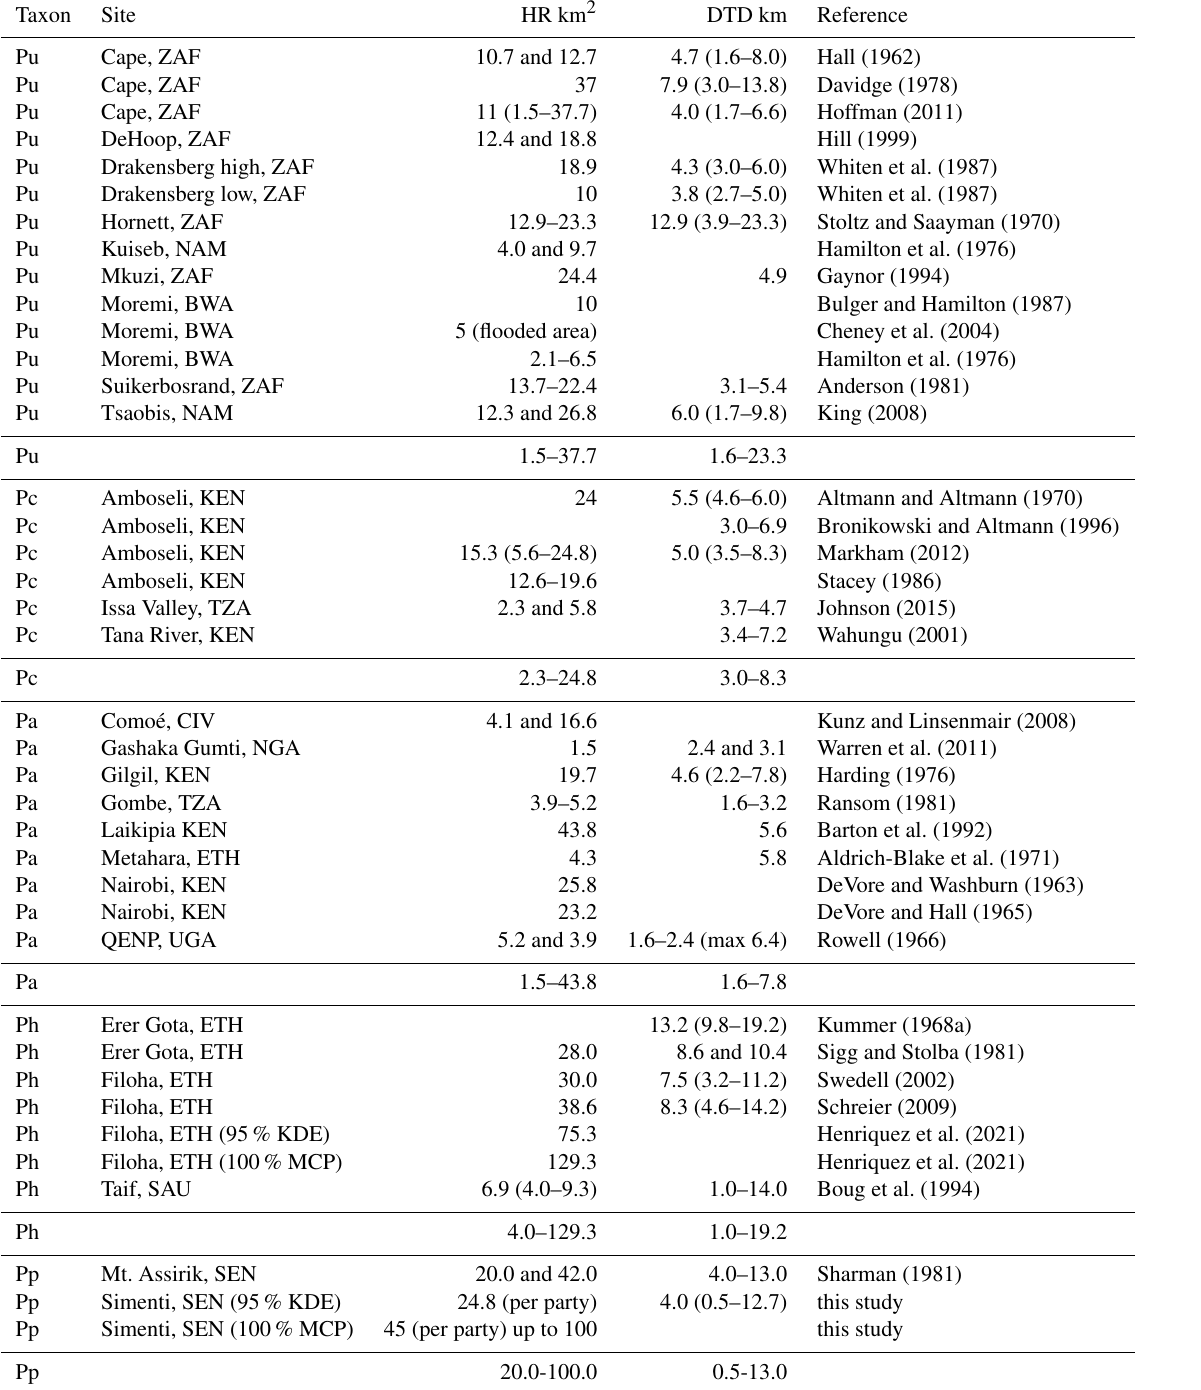
Table 2. Home range size (HR) and daily travel distance (DTDs) of baboons. Depending on the study, these data represent single values, means, and/or ranges. Since the estimations of HR and DTD are based on different group sizes and since different methods were used, the values are only comparable to a limited